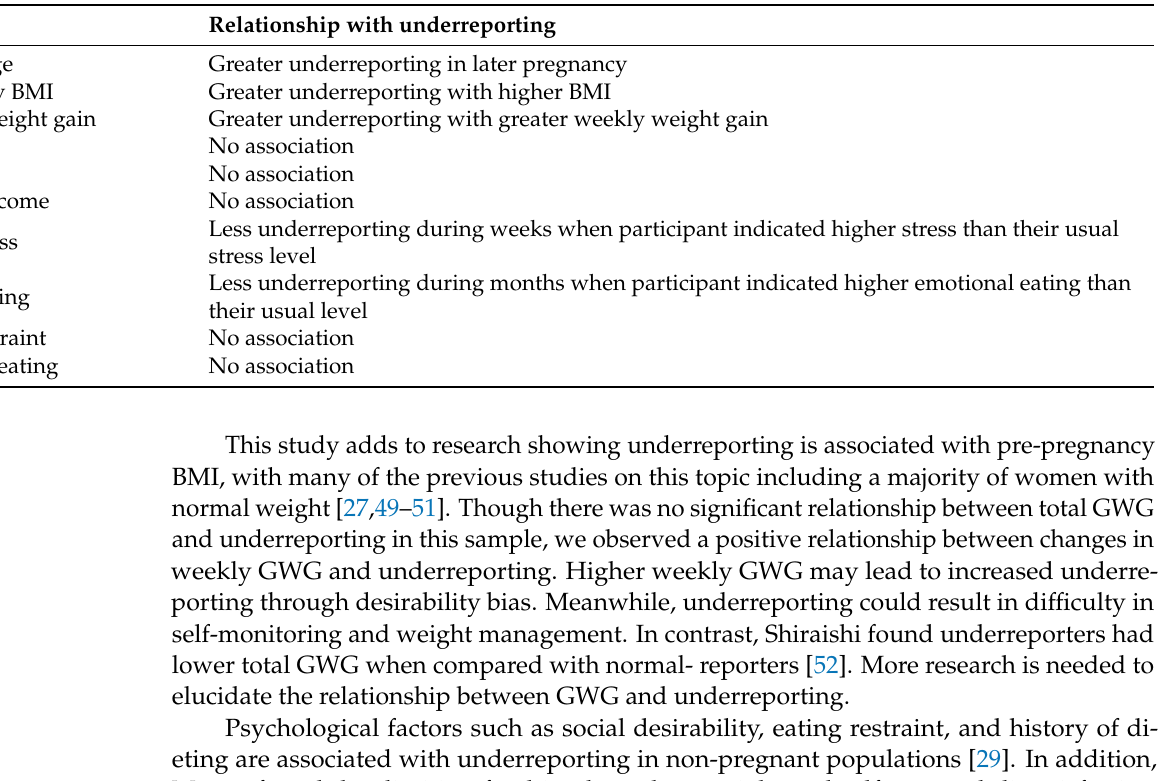
Table 4. Summary of associations between participant characteristics and energy intake